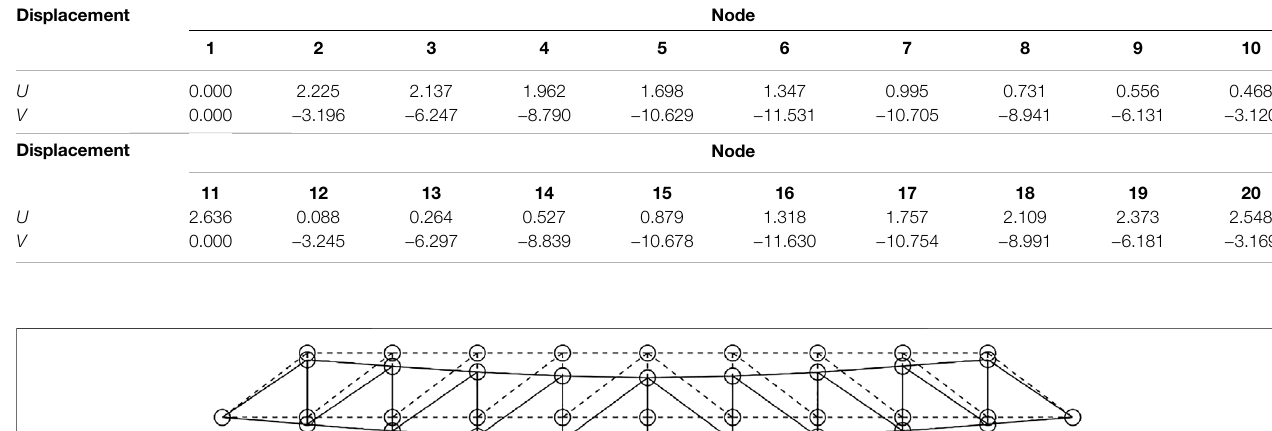
TABLE 6 | Displacement values of unit nodes (mm).